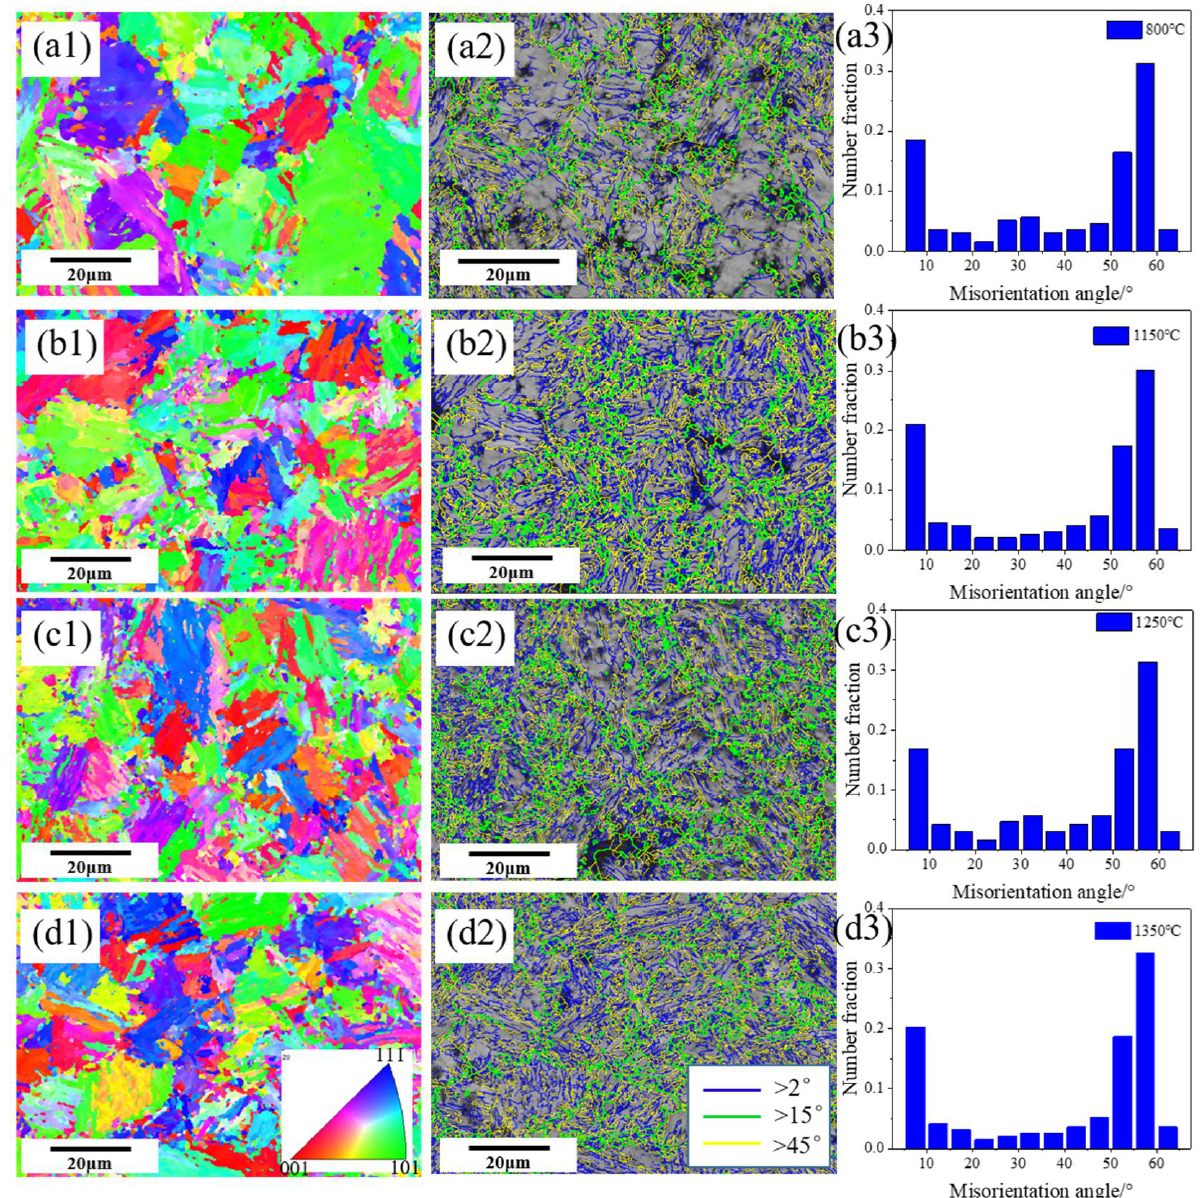
Figure 11. Crystallographic characteristics of the welded joint at different peak temperatures: ( a1 – d1 ) EBSD inverse pole figure (IPF); ( a2 – d2 ) grain boundary maps; ( a3 – d3 ) misorientation angle distribution histograms; ( a 1– a3 ) 800 ◦ C; ( b1 – b3 ) 1150 ◦ C; ( c1 – c3 ) 1250 ◦ C; ( d1 – d3 ) 1350 ◦